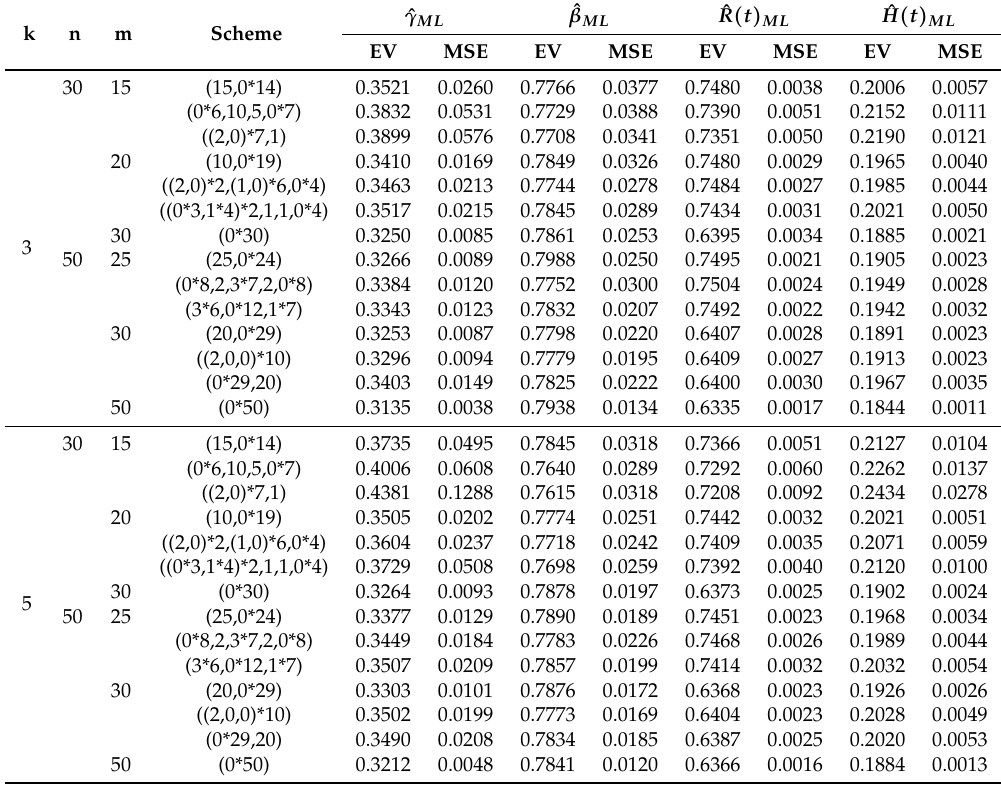
Table 2. Maximum likelihood estimates and MSEs of parameters and reliability and hazard functions when γ = 0.3, β = 0.8, t = 1.5, R ( t ) = 0.7563, H ( t ) = 0.1786, N = 1000.